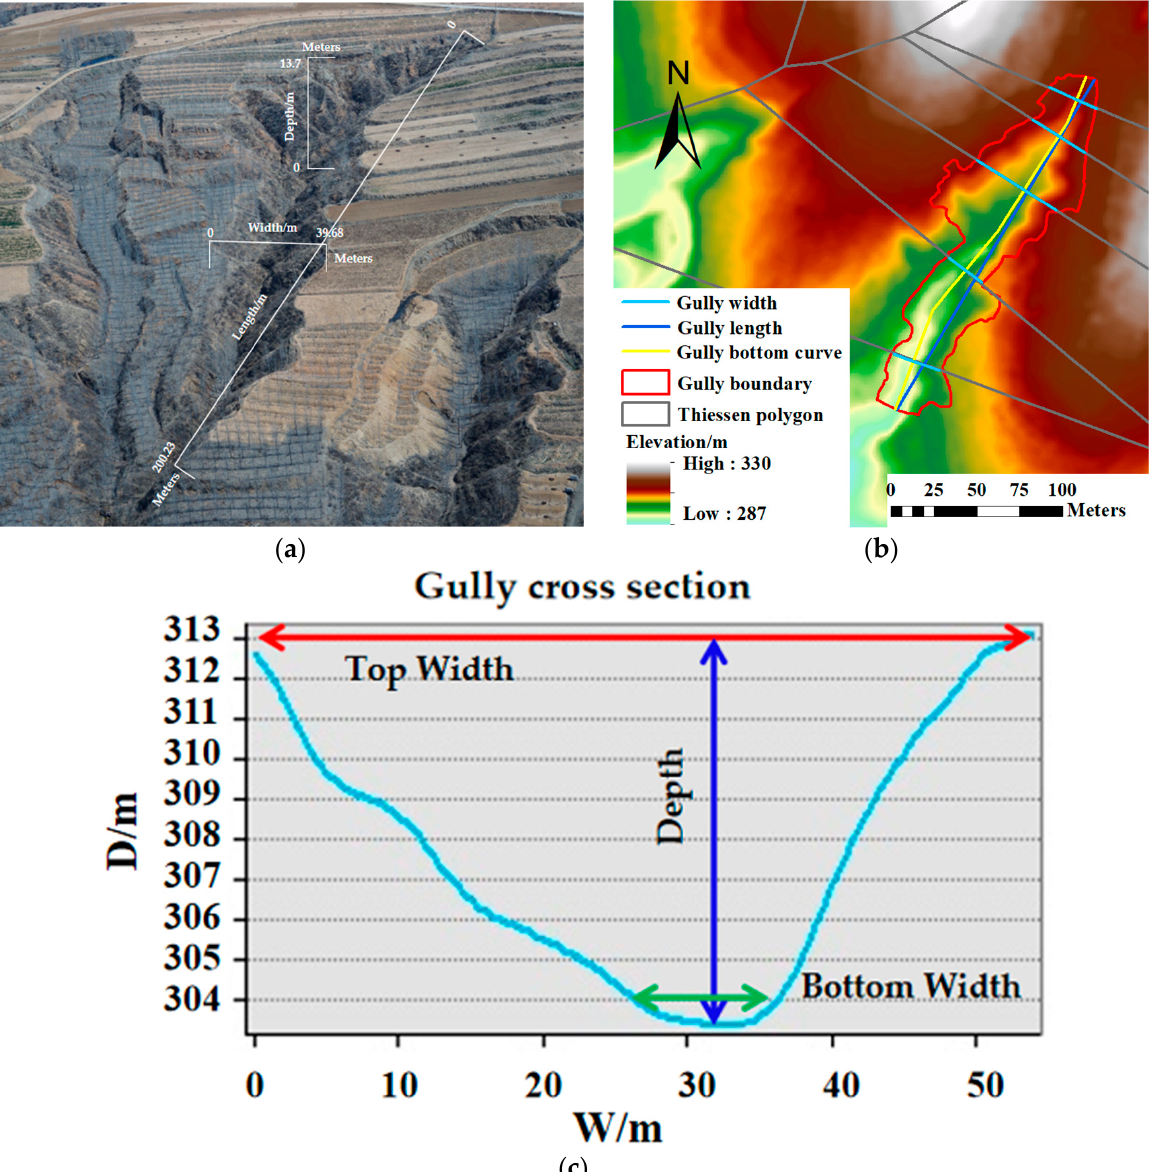
Figure 4. ( a – c ) Example of typical gully length, width, depth and cross section. The gully volume ( V ) was estimated in terms of the higher-precision parameters L , TW, BW, D and A . The gullies in the study area were investigated on the spot through the close observation of their characteristics. The gullies with a typical morphology (wedge shape, lane shape or palm shape) and an obvious gully edge line were visually interpreted, and their distribution was reflected in the high-resolution RS images [45]. Through the same procedure, the morphological parameters L , TW, BW, D and A of 43 gullies were extracted from the DEM and DOM data acquired from the two periods of high ‐ resolution RS stereopair images for building a gully volume estimation model in large dimensions and calculating the gully erosion rate. The length, width and area of the gullies in the